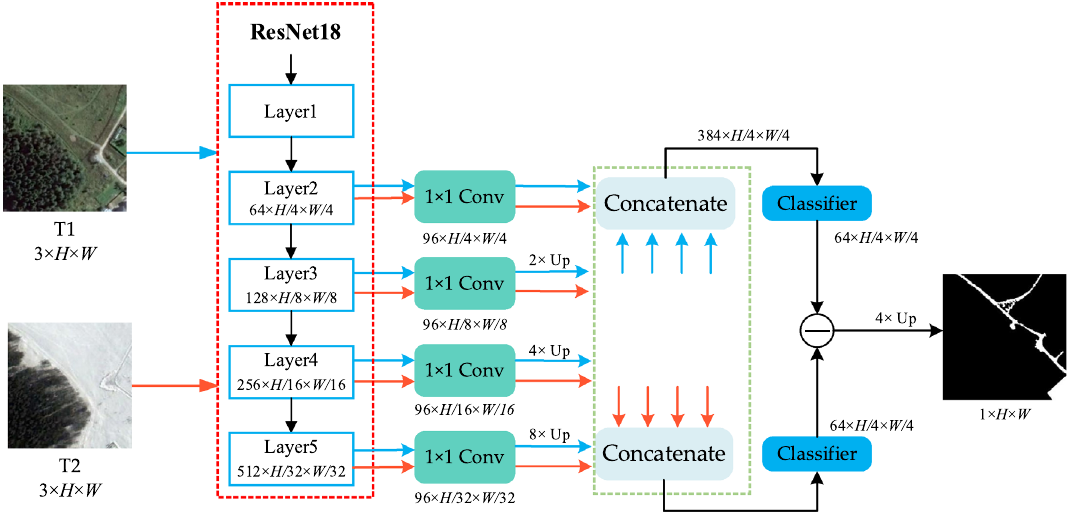
Figure 8. The structure of baseline (created by ‘Microsoft Office Visio 2013’ url: https:// www. micro soft. com/ zh- cn/ micro soft- 365/ previ ous- versi ons/ micro soft- visio-